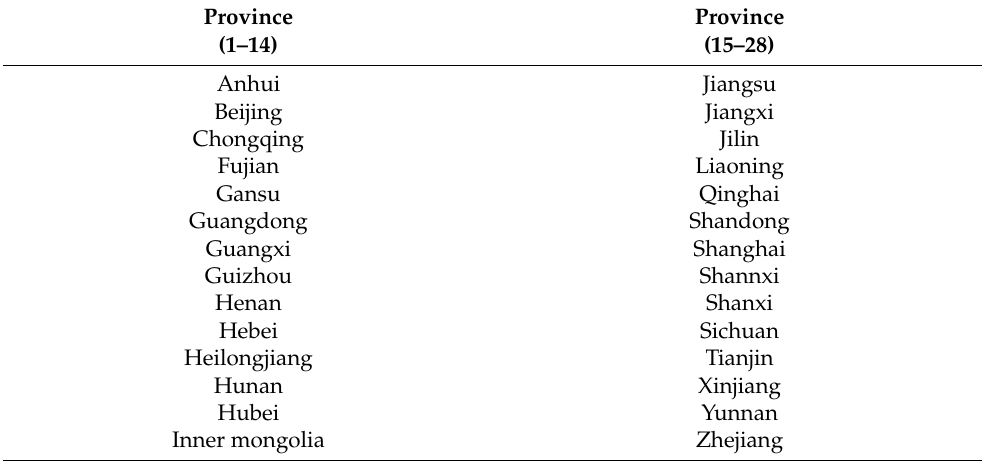
Table 1. The 28 provinces from which the CHARLS baseline survey samples came from .